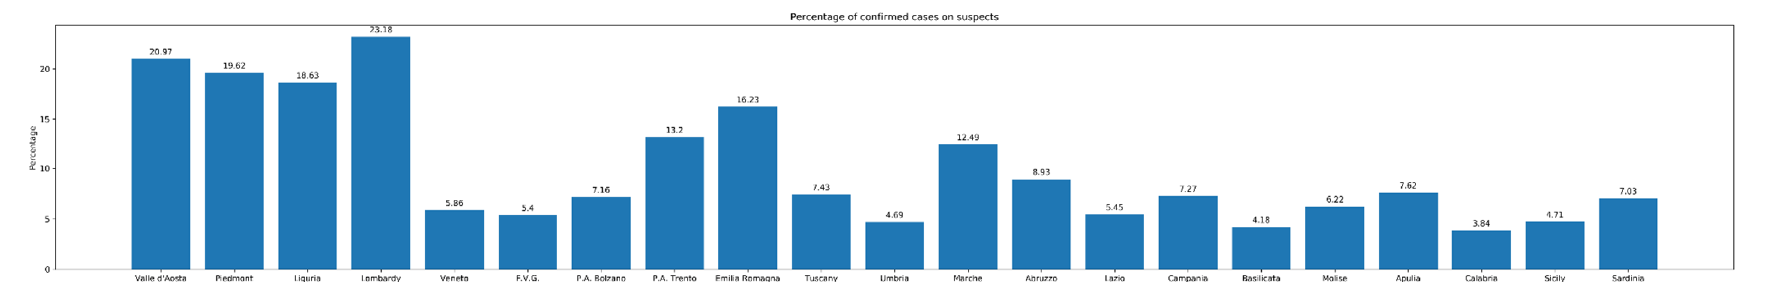
Figure 4. Percentage of suspects confirmed as of 23 Apri. Between 28 and 29 March, Lombardy increased by 10% with respect to the previous 24 h.